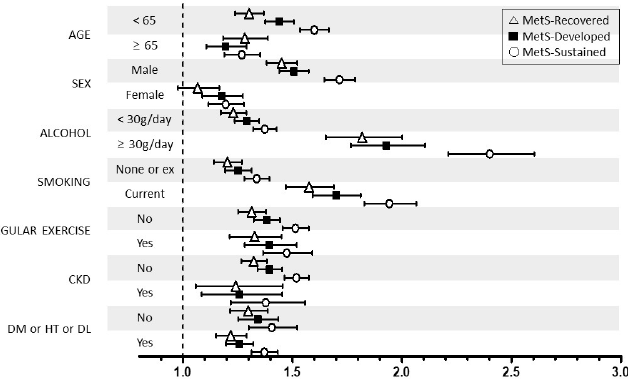
Figure 2. Relationship between the change in MetS status and liver cirrhosis stratified by patient characteristics. MetS, metabolic syndrome. CKD, chronic kidney disease; DM, diabetes mellitus; HT, hypertension; DL, dyslipidemia * Adjusted for age, sex, smoking, alcohol intake, and exercise.